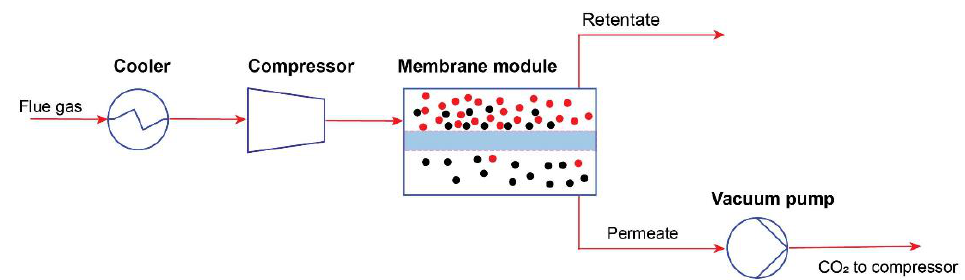
Figure 7. Flow diagram of basic membrane technology for CO 2 capture (Based on [22]).